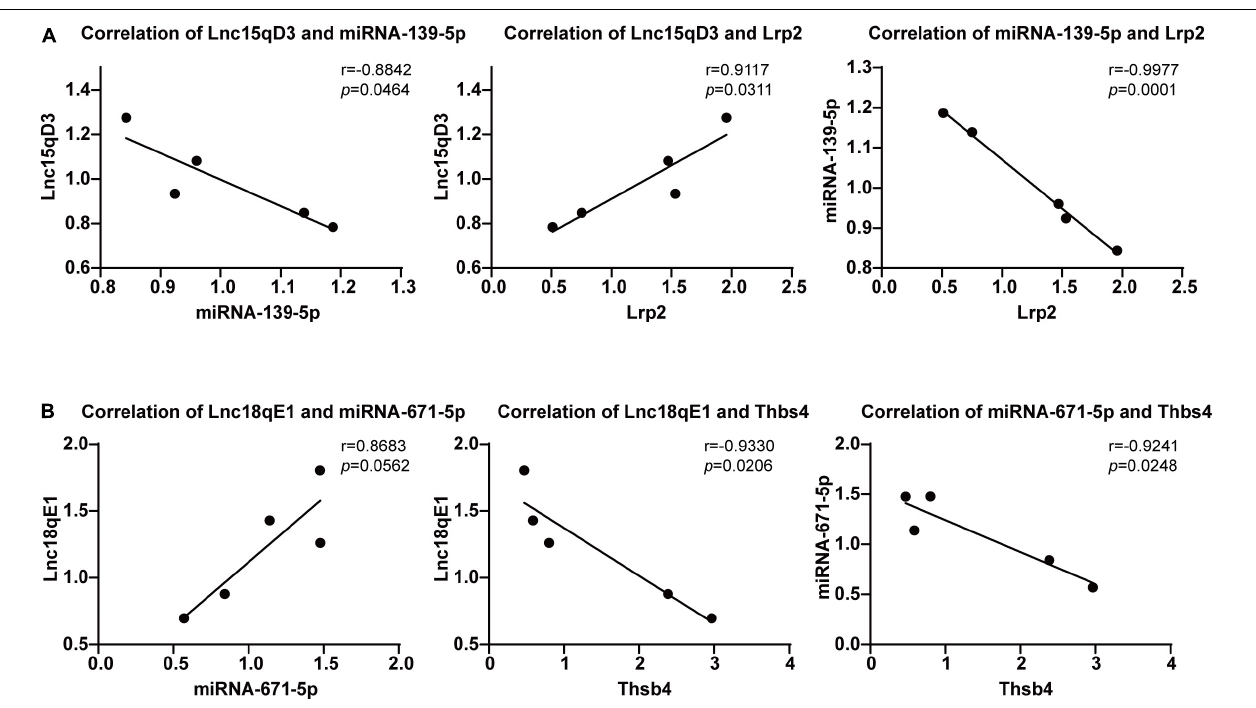
FIGURE 6 | Regression analyses of the ceRNA network. The correlations of Lnc18qE1-miR-671-5p-Thbs4 (A) and Lnc15qD3-miR-139-3p-Lrp2 (B) were determined by